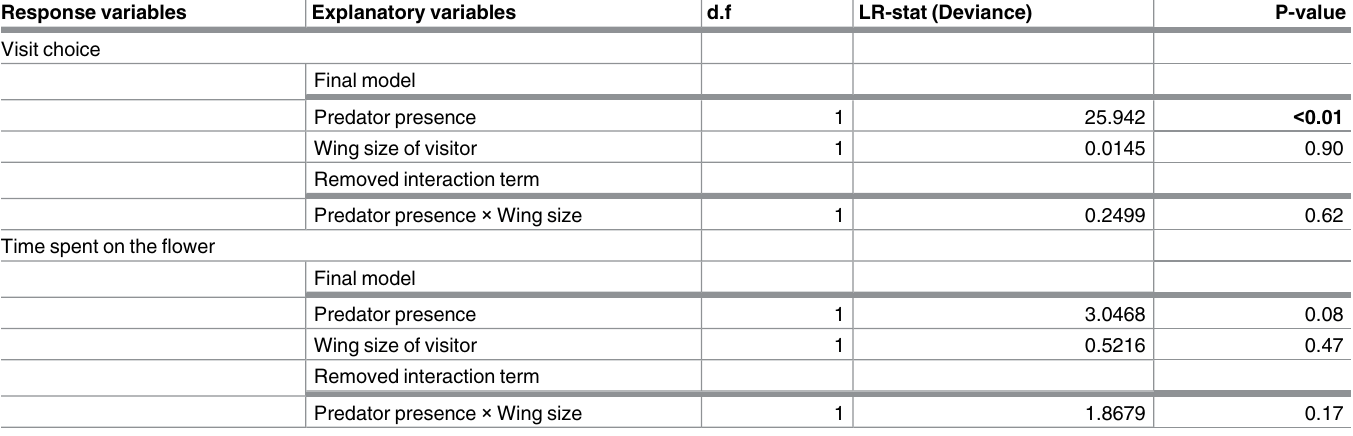
Table 1. Effects of presenceof dead predator, wing size of the visiting butterfly species and the interaction on the visit choice and the time spent on the flower. Response